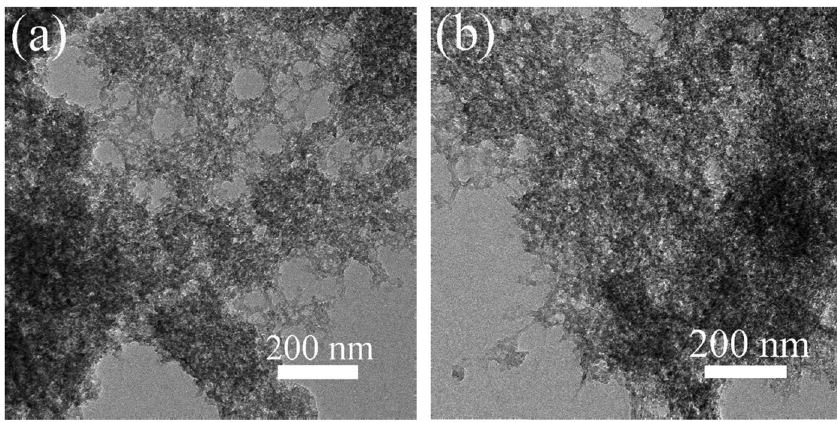
Figure 5: TEM images of ( a ) TBrTh – BTBPE – CTF and ( b ) CTF – TMZ.